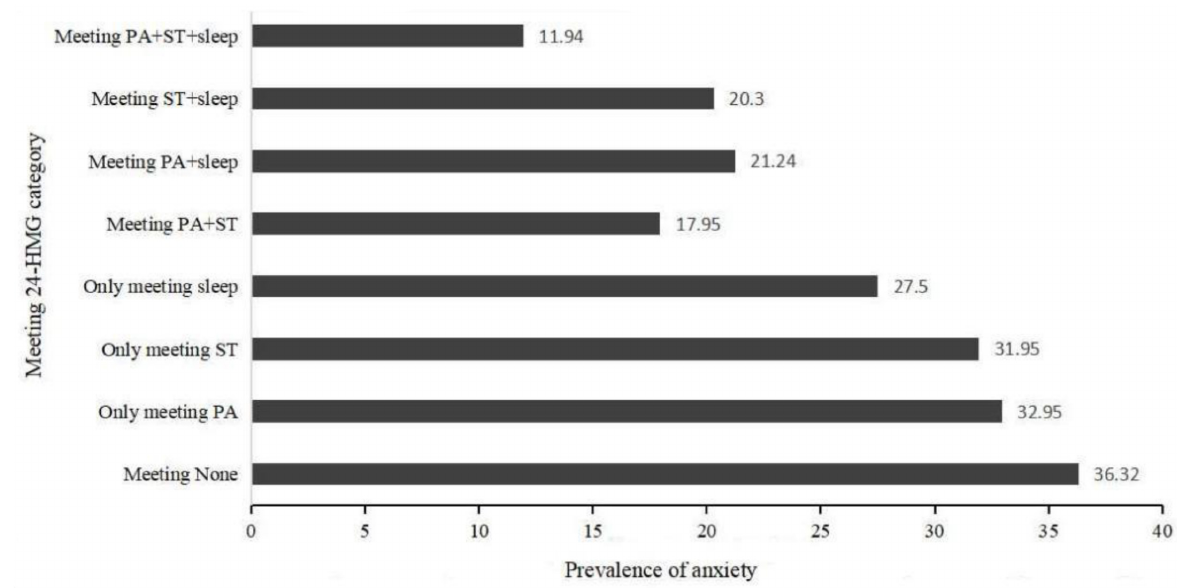
Figure 1. Prevalence of anxiety in different groups of adolescents.